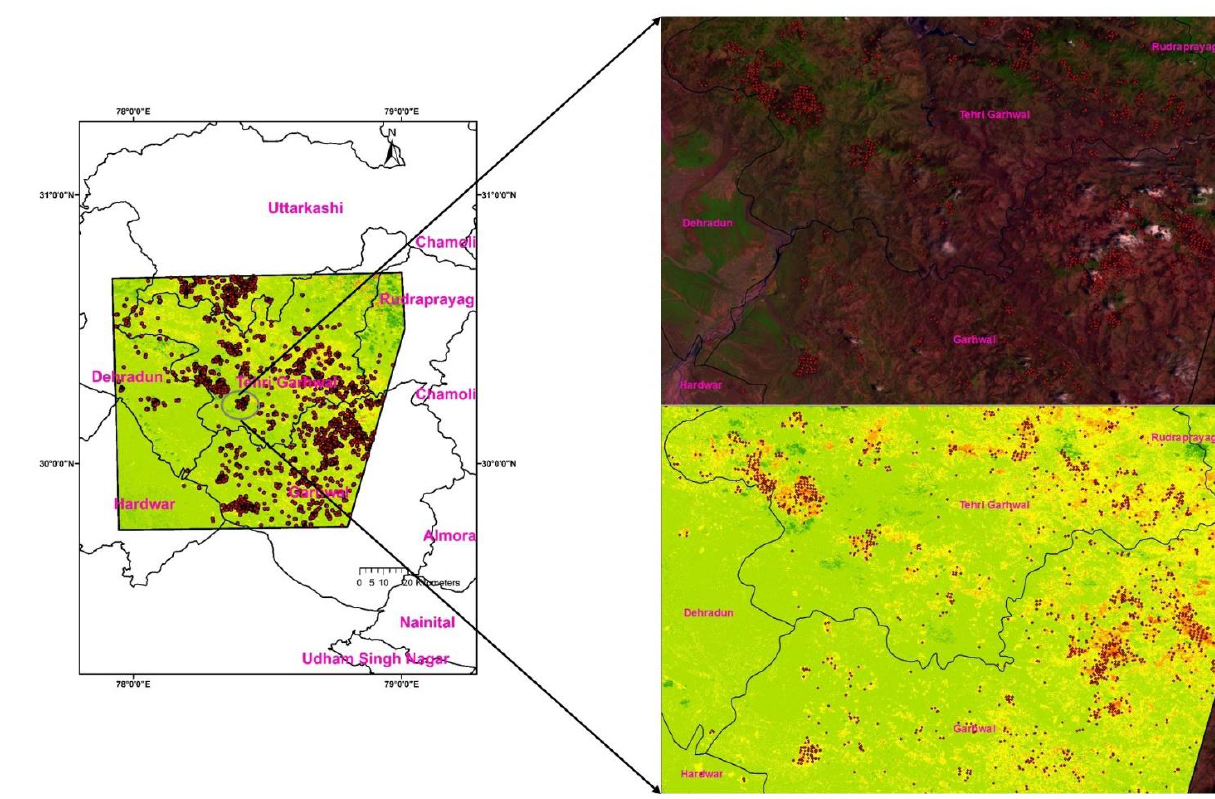
Figure 3. Burn severity map and zoomed extent shows the active fire hotspots overlaid on the various severity levels.